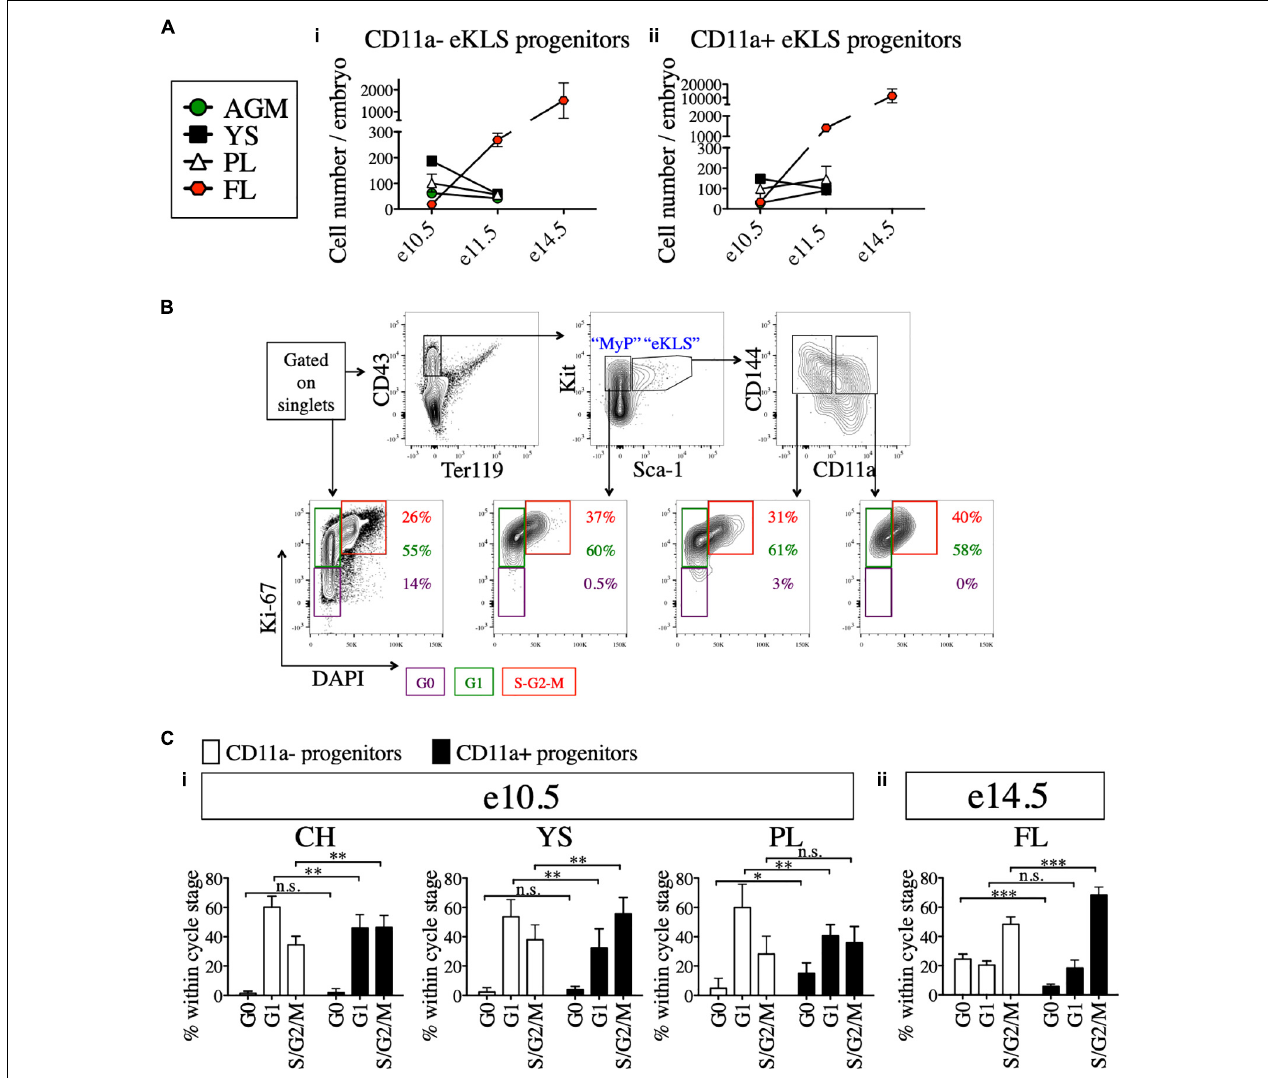
FIGURE 4 | Cell cycle analysis of 11a- eKLS cells and CD11a+ progenitors. (A) Numbers of CD11a- and CD11a+ progenitors in embryos over time. Estimated number of CD11a- progenitors (i) and CD11a+ progenitors (ii) per embryo is depicted in embryonic tissues at e10.5, e11.5, and e14.5. “eKLS progenitors” are defined as Ter119- CD43+ Sca1+ Kit+ CD144+ at e10.5 and e11.5, and as Ter119- CD43+ Sca1+ Kit+ EPCR+ at e14.5. e10.5, n = 4 (two independent experiments); e11.5, n = 5 (three independent experiments; e14.5, n = 10 (two independent experiments). (B) Representative analysis of the cell cycle status in embryonic population. Bottom plots show DAPI (x-axis) and Ki-67 (y-axis) within total single cells, myeloid progenitors (MyP), 11a- eKLS, and 11a+ eKLS from left to right. The color of percentage values inside the gates correlate with the color of each gate/cell cycle phase. e10.5 CH is shown as a representation. (C) Cell cycle analysis of CD11a- and CD11a+ progenitors at e10.5 and e14.5. Cell cycle status of each population is depicted for e10.5 tissues (i) and e14.5 FL (ii) . “Progenitors” are defined as Ter119- CD43+ Sca1+ Kit+ CD144+ at e10.5, and as Ter119- CD43+ Sca1+ Kit+ CD150+ at e14.5. ∗ p ≤ 0.05, ∗∗ p ≤ 0.01, and ∗∗∗ p ≤ 0.001 (Student’s unpaired t test) e10.5, n = 8 (two independent experiments); e14.5 = 5 (two independent